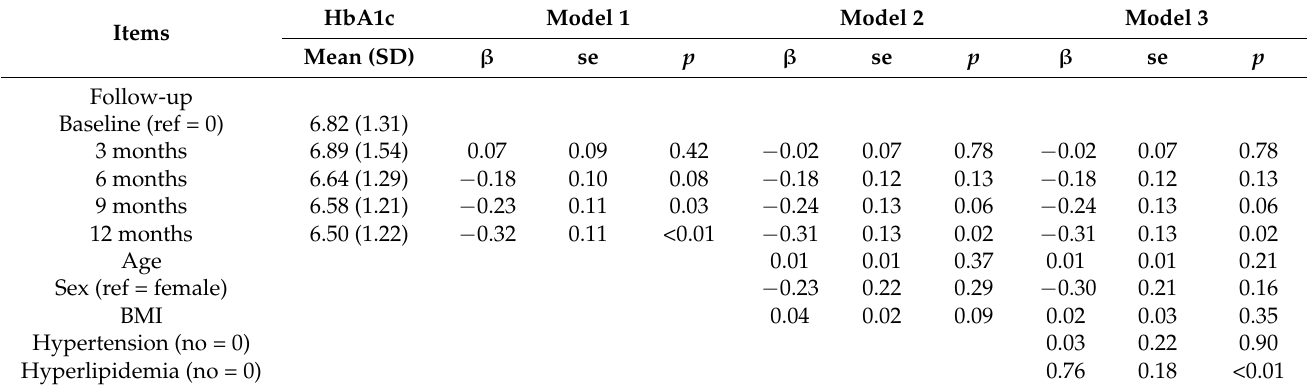
Table 2. Change in the HbA1c levels of diabetic psychiatric patients after implementing P4P intervention for one